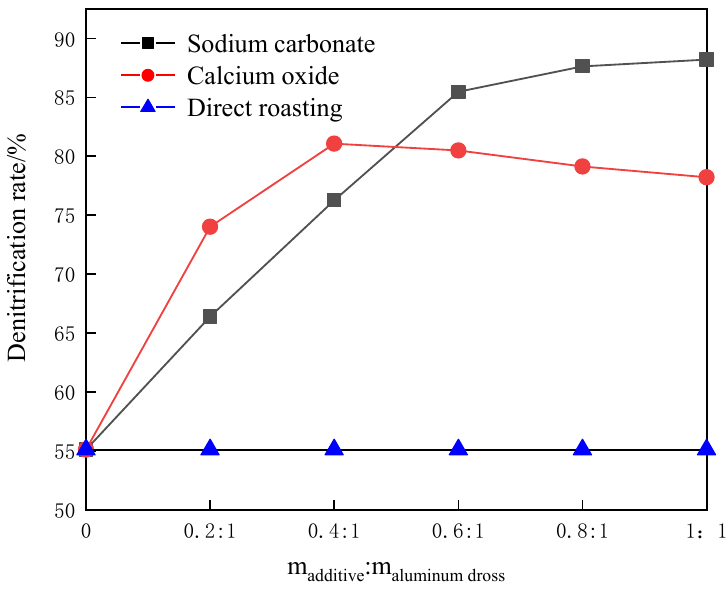
Figure 4. Denitrification rate of aluminum dross varies with mixture ratio.